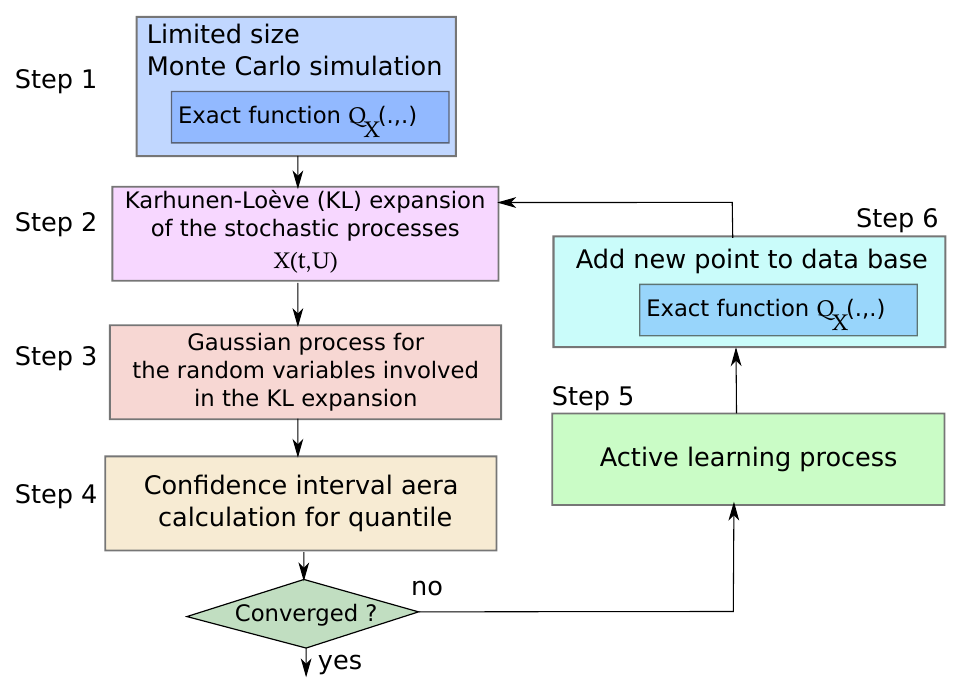
Figure 3. Proposed active learning strategy for quantile estimation refinement for stochastic process defined over a mono-dimensional mesh